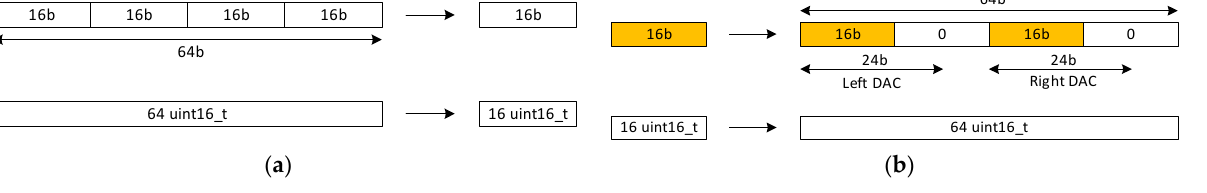
Figure 12. Data flow control for the receiver realization: ( a ) PDM to PCM conversion; ( b ) DAC